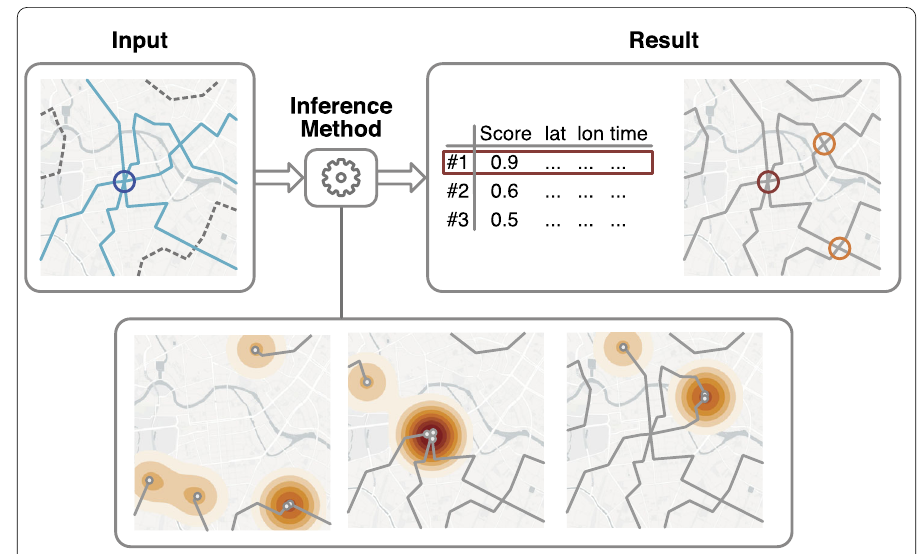
Figure 1 Illustration of the inference method. The input is a sample of GPS trajectories of individuals that have visited the outbreak origin (blue circle). The input sample may also include trajectories of other, unaffected individuals (grey, dashed lines). The method aims to infer location and time of the outbreak from GPS data. To this end, the algorithm identifies occurrences when individuals have been in close proximity of each other by searching for local maxima in the spatial distribution of individuals. The most prominent of these maxima is then identified as the estimated outbreak